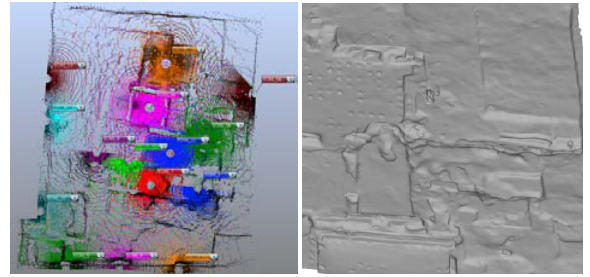
Figure 2. The 14 acquired scans (false color, left) and a zoom of the achieved 3D model (right).